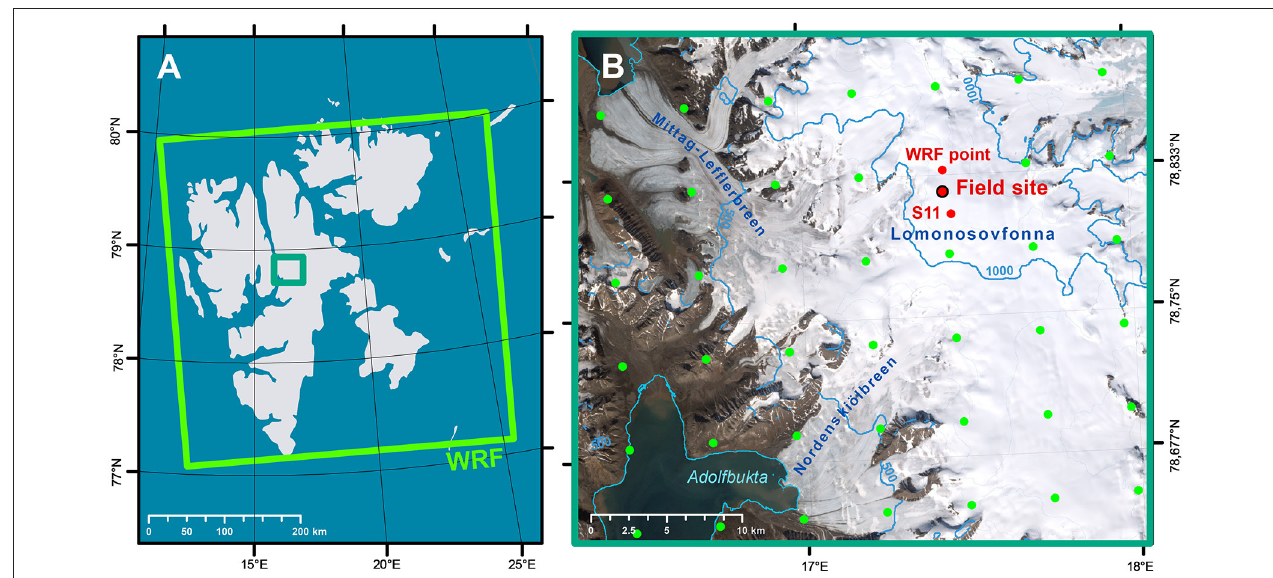
FIGURE 1 | (A) Svalbard archipelago, large green polygon shows the extent of WRF domain, smaller dark-green polygon marks the area shown in (B) . (B) Lomonosovfonna and its outlet glaciers. Green dots show locations of the WRF domain nodes; large red dot marks location of the AWS and thermistor strings (detailed sketch of installation is found in Marchenko et al., 2017: thermistor strings were installed in boreholes 1–9); smaller red dots show the WRF domain node, output for which was used to force the surface energy balance model and location of the stake S11. Background - true color satellite image LANDSAT ETM July 2002, contour lines and coastline data is provided by the Norwegian Polar Institute.